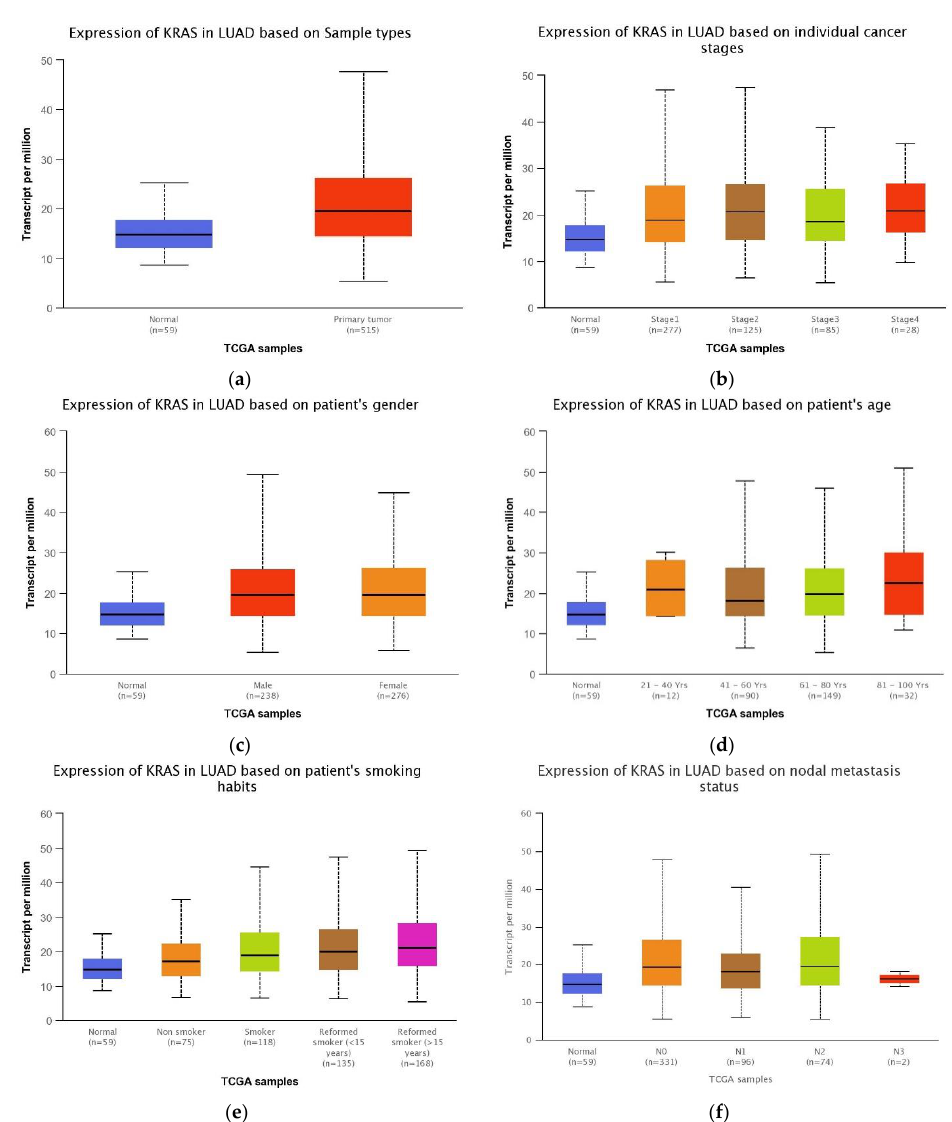
Figure 3. KRAS expression profile in lung adenocarcinoma. Box-whisker plots show the expression of KRAS in normal and tumor samples ( a ), tumor subgroups based on individual cancer stages ( b ), patient sex ( c ), age ( d ), smoking status ( e ), nodal metastasis ( f ) (Data derived from the UALCAN server (http://ualcan.path.uab.edu/ (accessed on 15 June 2022))). KRAS expression was also strongly associated with smoking status, regardless of the time that they had stopped smoking before the diagnosis or of whether they were active smokers. Significant differences in expression levels were found between normal vs. non-